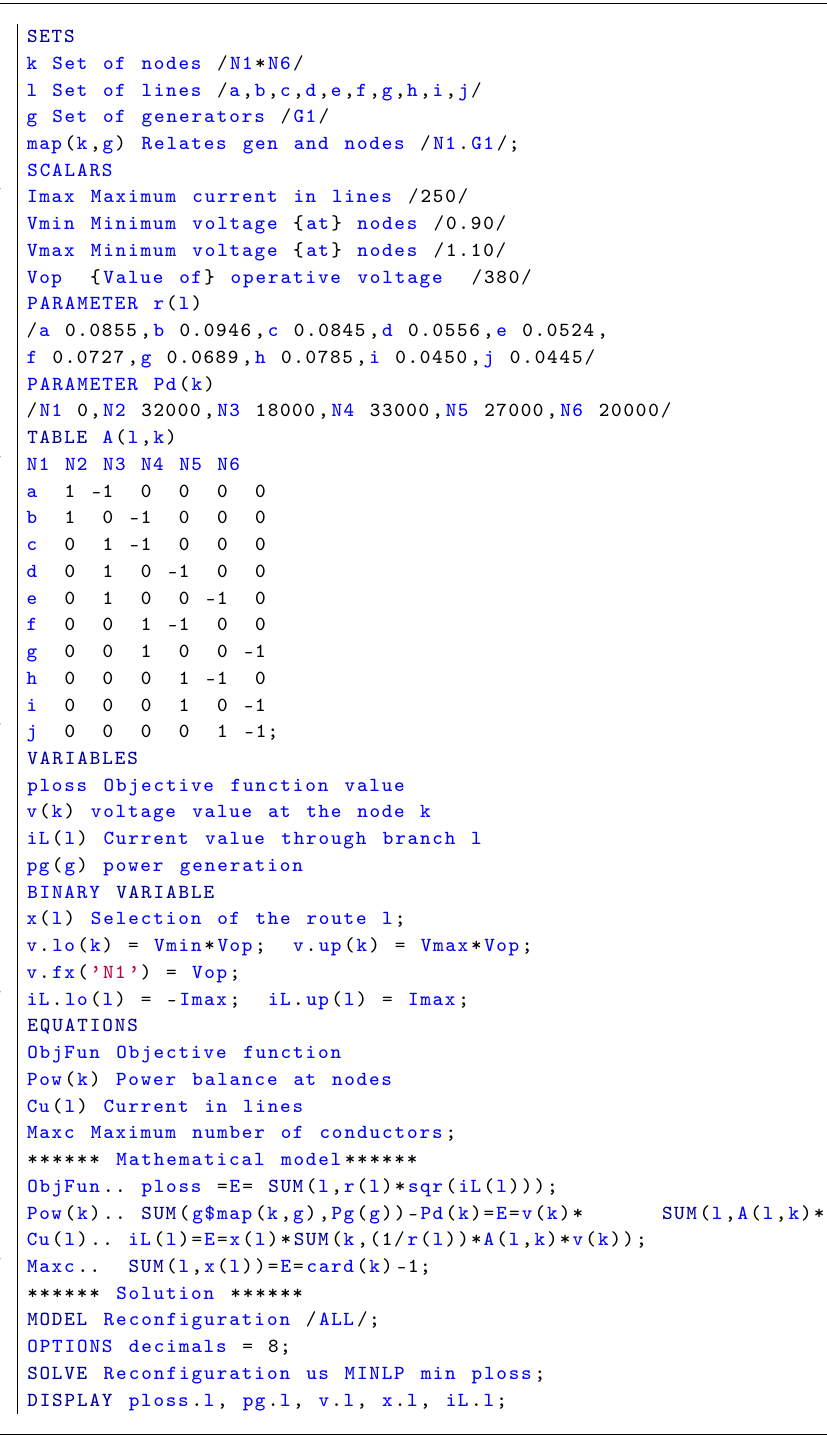
Algorithm A1: GAMS implementation of the reconfiguration problem in the 6-nodes test